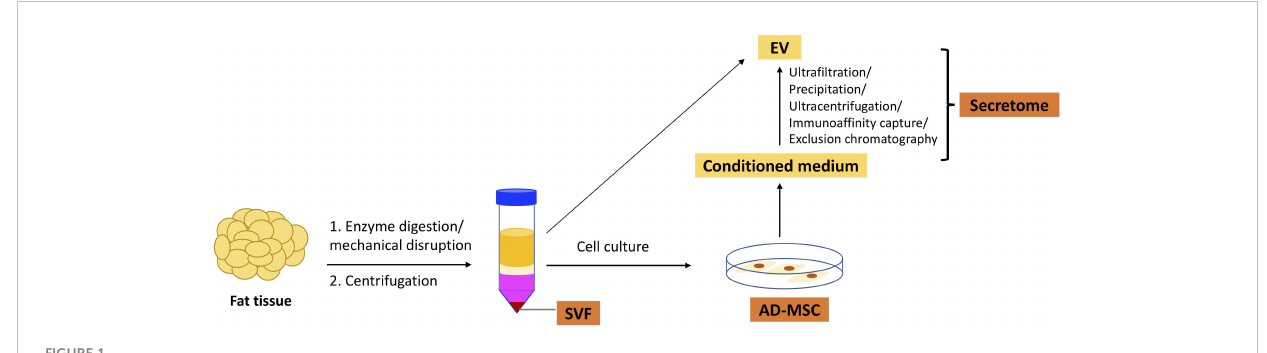
FIGURE 1 Isolation of adipose tissue-derived therapeutics from the fat